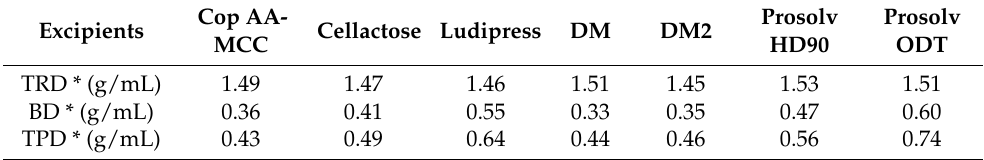
Table 1. True (TRD), bulk (BD), and tapped (TPD) density of the different tested materials.